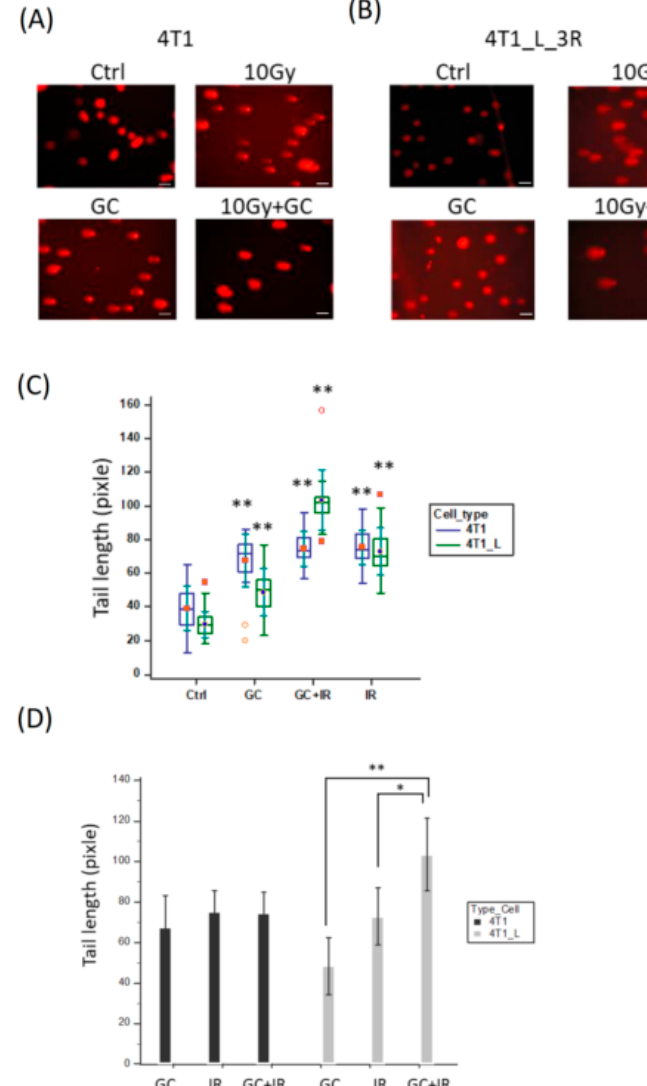
Figure 4. DNA damage analysis in cells exposed to X-rays with or without the GC pre-treatment. ( A , B ) Comet assay for parental 4T1 cells and 4T1_L_3R cells treated with GC, X-rays (10 Gy) or combined treatment, respectively. Scale bar = 50 µ m. ( C ) Tail lengths determined by the comet assay were compared for untreated control, GC-treated, X-ray-treated, and combined treatment groups, and the results were analyzed using two-way ANOVA; ** p < 0.001. The data were presented as a box-and-whisker plot, where the central box represented the values from the lower to upper quartile (25 to 75 percentile). The middle line represented the median, and the dots in the middle position of the boxes represented central value markers. The far out values were displayed as open or solid circles. ( D ) Tail lengths were compared in cells subjected to combined treatment and individual GC or X-rays treatments. The results were analyzed using the t -test; * p < 0.05; ** p <